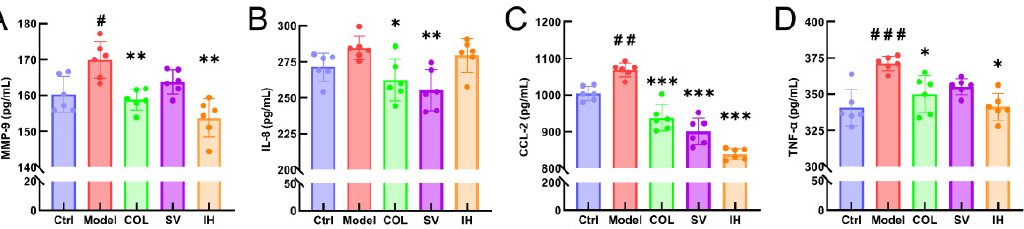
Figure 5. SV and IH inhibited the inflammatory response in acute gouty arthritis rats. The effects of SV and IH on the serum levels of MMP-9 ( A ), IL-8 ( B ), CCL-2 ( C ), and TNF- α ( D ) in acute gouty arthritis rats. Data are shown as means ± SD ( n = 6 rats/group). # p < 0.05, ## p < 0.01, ### p < 0.001 vs. Ctrl group, * p < 0.05, ** p < 0.01, *** p < 0.001 vs. model group.